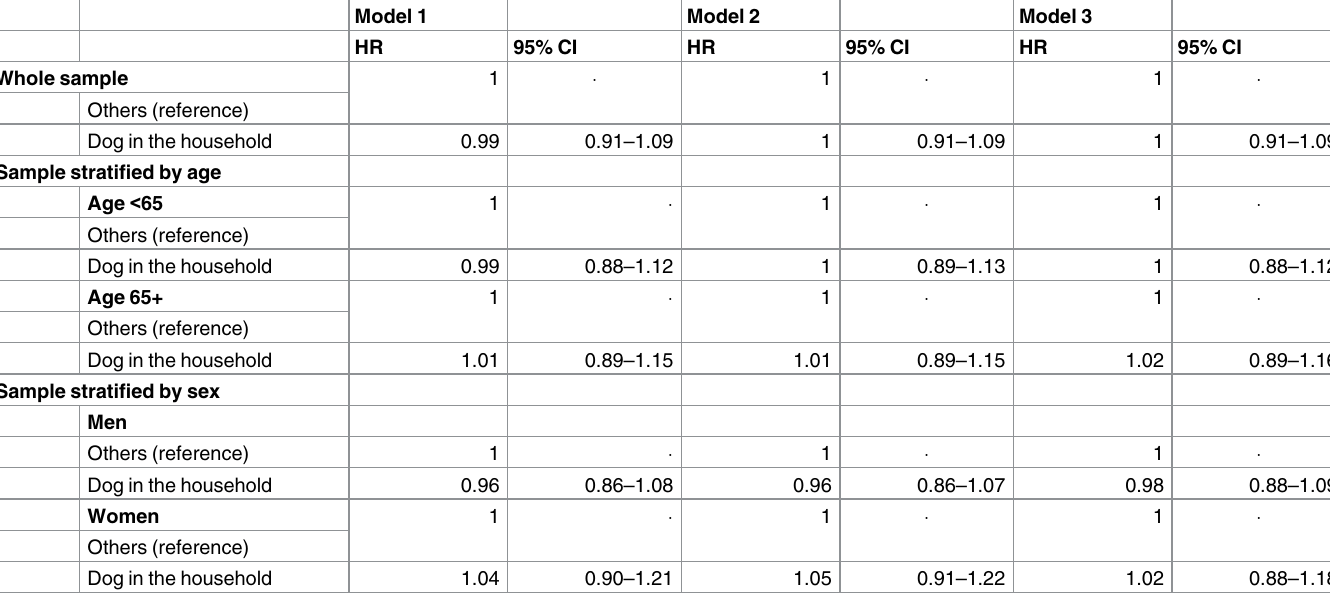
Table 2. The hazard ratios of death in dog owners compared to people who do not own a dog.